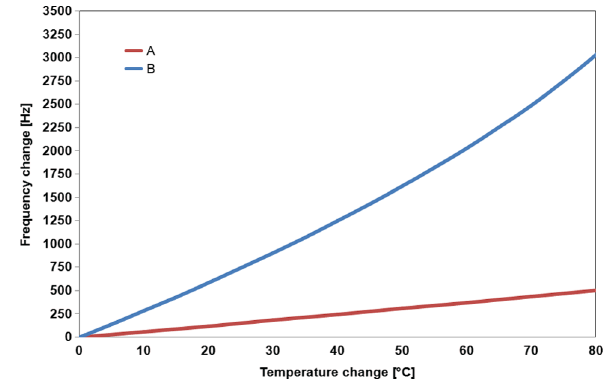
FIG. 4. Frequency dependence on the target wire temperature (curve A). Frequency dependence on the ambient temperature (curve